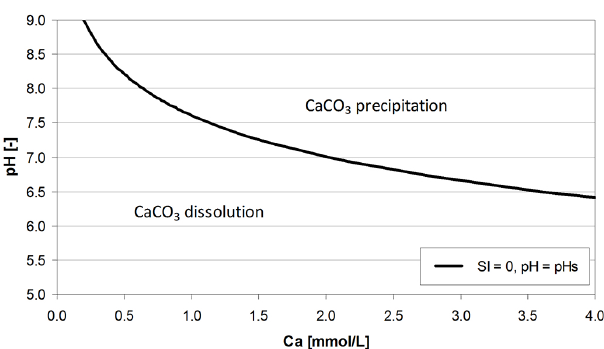
Figure 1. Calcium carbonate equilibrium or saturation (SI = 0, at 25 ◦ C and {HCO − } = 2 {Ca 2 + }) with over- and under-saturation i.e. 3 calcium carbonate precipitation and